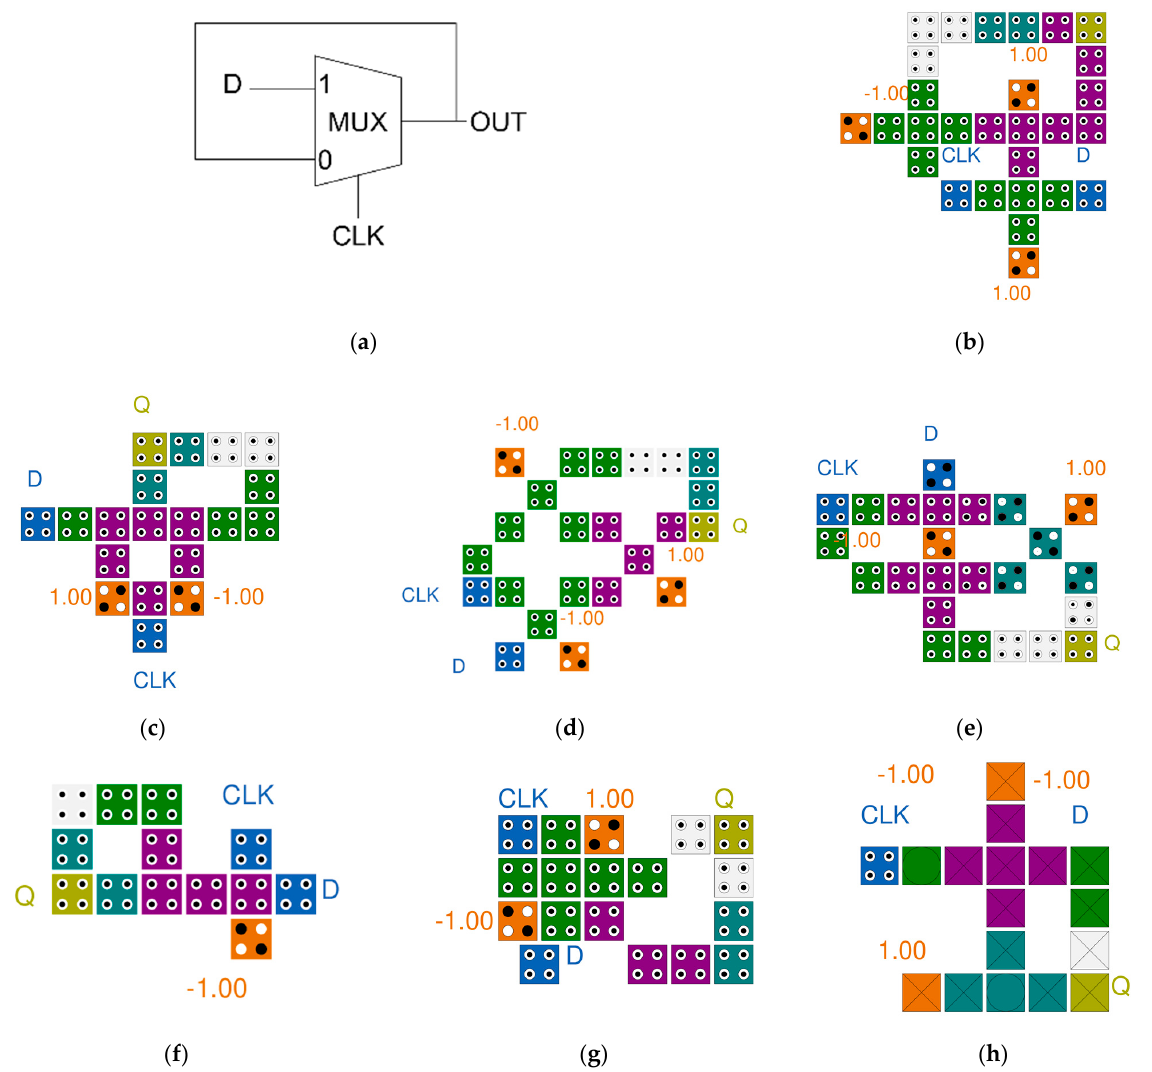
Figure 5. Previous D-latches: ( a ) a logic diagram of D-latch; ( b ) M. M. Abutaleb’s [20]; ( c ) M.